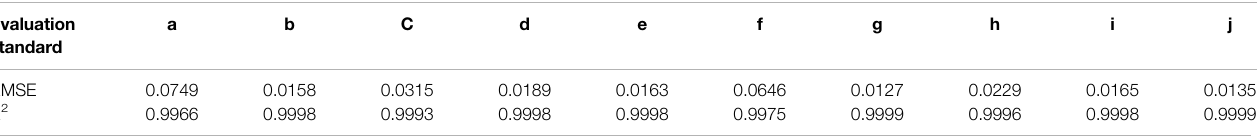
TABLE 5 | Comparison of kernel function precision. Evaluation standard